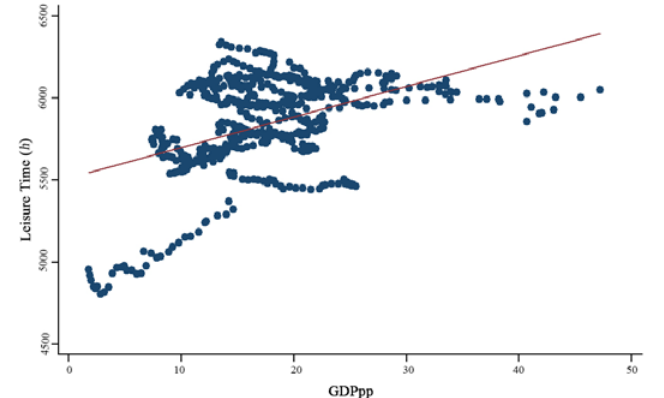
Figure 5: The correlation between leisure time and labor production in these 16 countries in 1980–2013